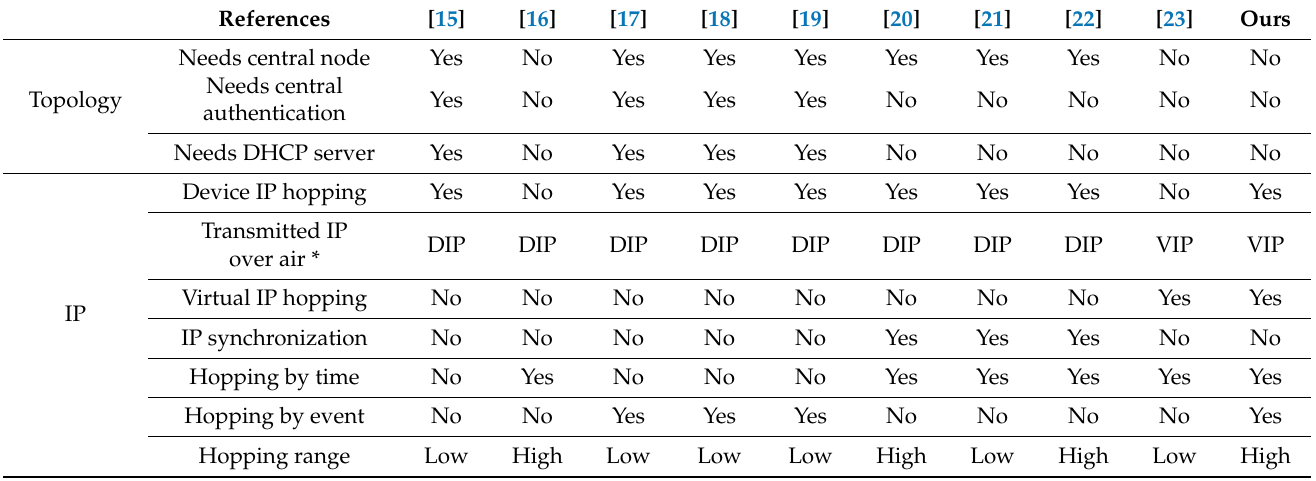
Table 1. Comparison of IP hopping